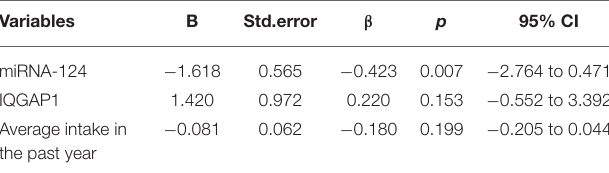
TABLE 4 | Linear regression analysis: analysis of independent influencing factors of MOCA score. Variables B